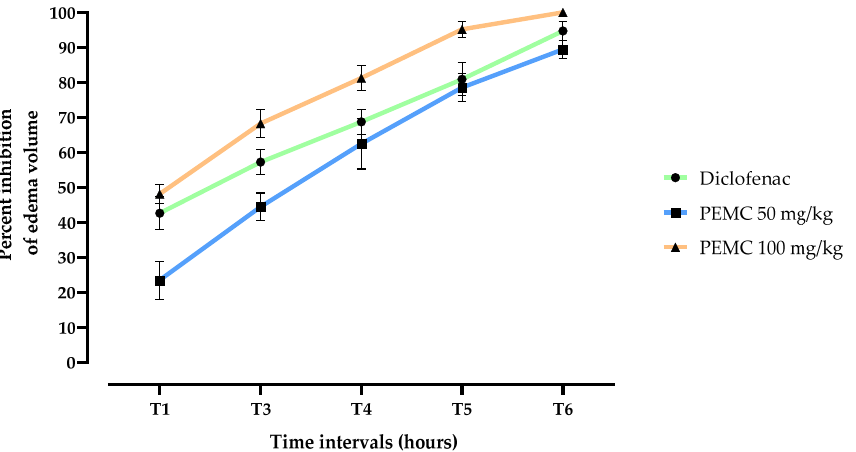
Figure 4. Inhibition percent of the edema volume after the treatment with PEMC. Results are expressed as mean ± standard deviation. The experiments were performed in quintuplicate.